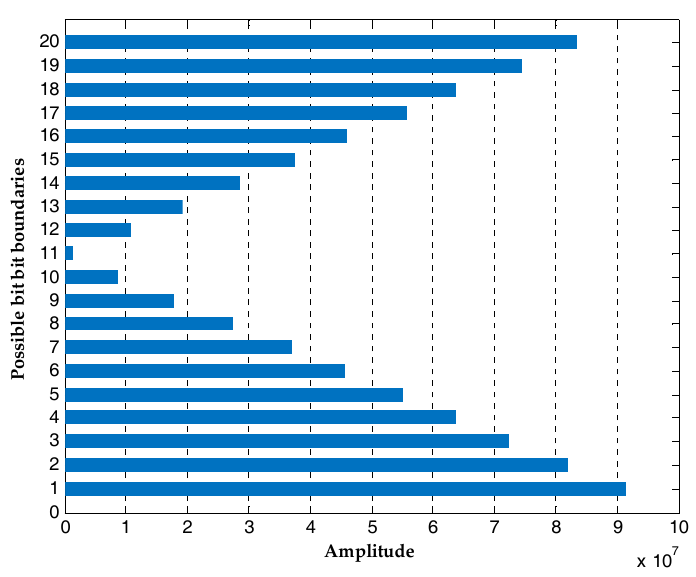
Figure 16. The differential coherent result of satellite #9.